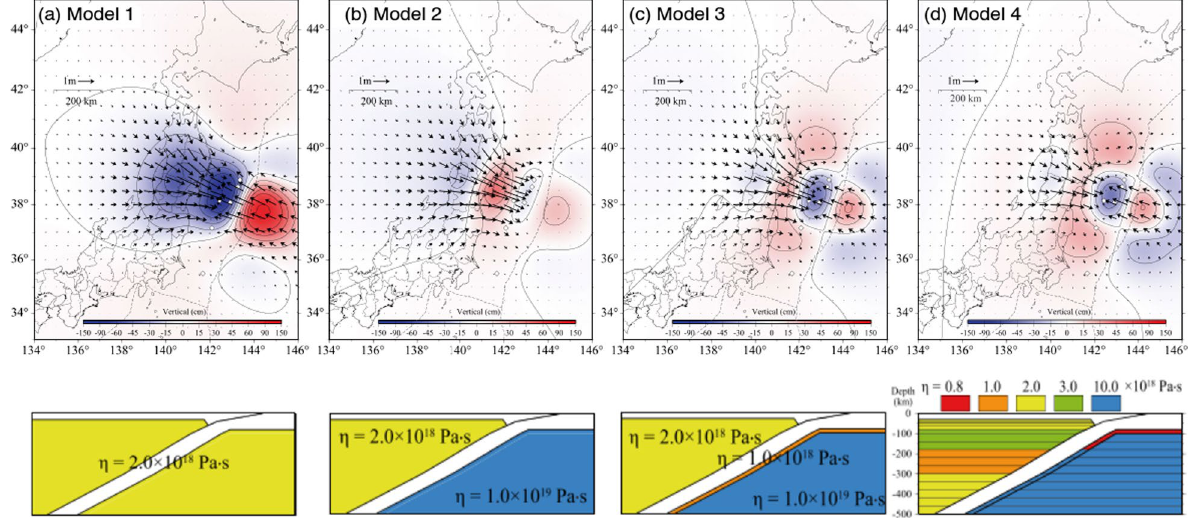
Fig. 9 The effect of depth-dependent rheology in the postseismic crustal deformation (after Suito